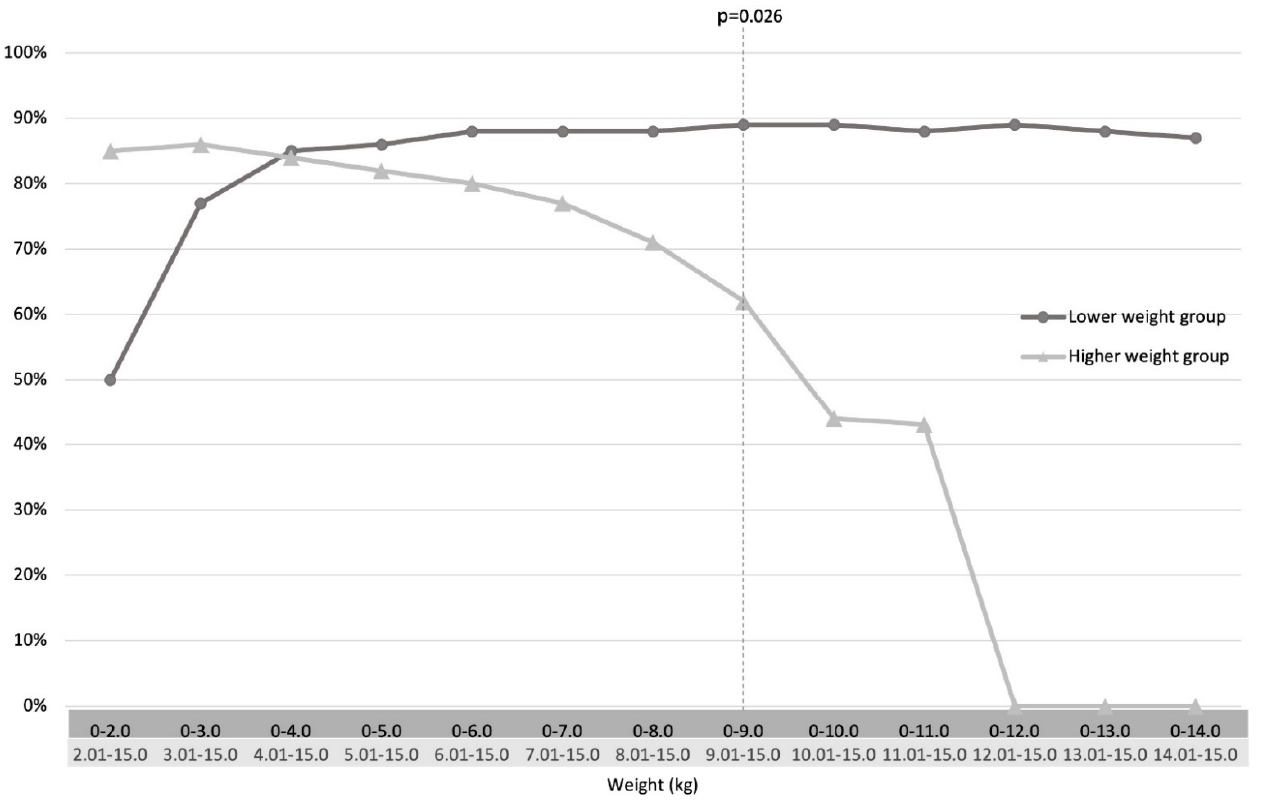
Figure 3. Rectal suction biopsy diagnostic efficacy, defined as sufficient specimen including submu- cosa for histopathological analyses, compared between weight groups. Cut-off was set when the group difference reached a significant value.